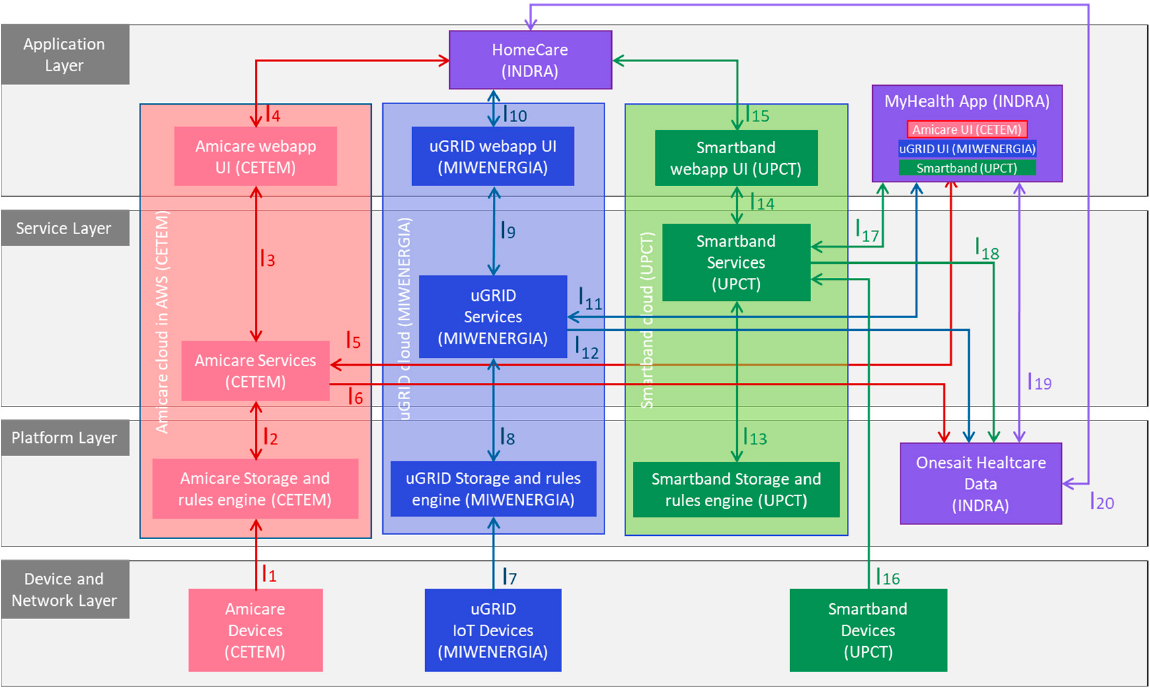
Figure 6. Murcia pilot high-level architecture.